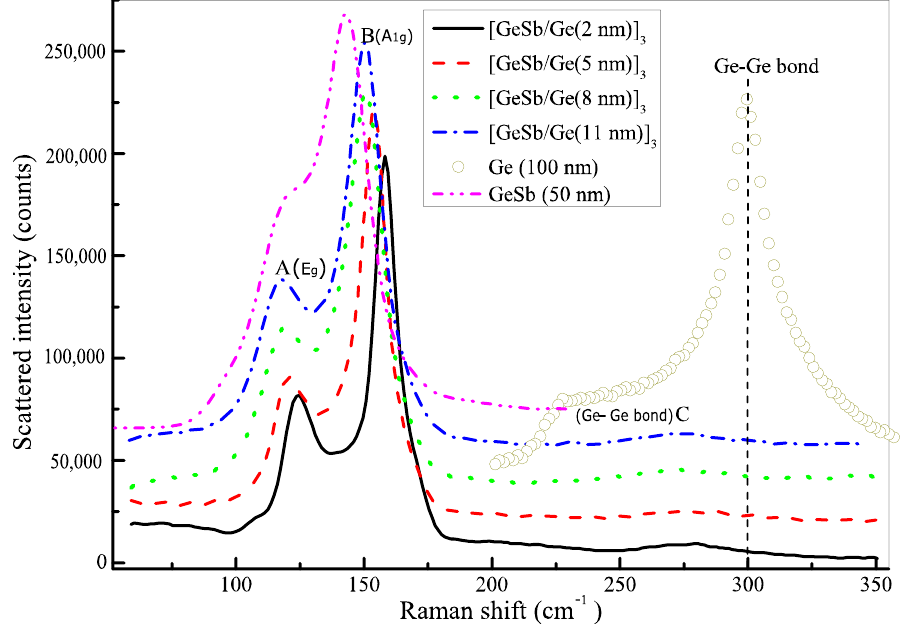
Figure 4. Raman spectra of four SLL films with different thickness of Ge layers and a 100 nm thick pure Ge film. The baseline of all curves is shifted upward for clarity except for the solid line